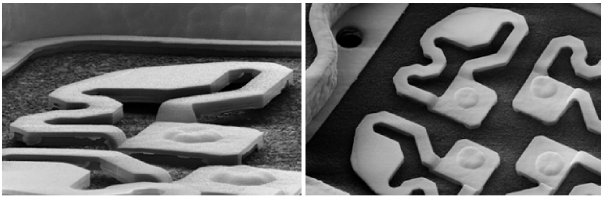
Figure 13. Copper springs in the cavity of the package. The springs are structured by photolithography. On the copper springs the sensor chip is flip-chip